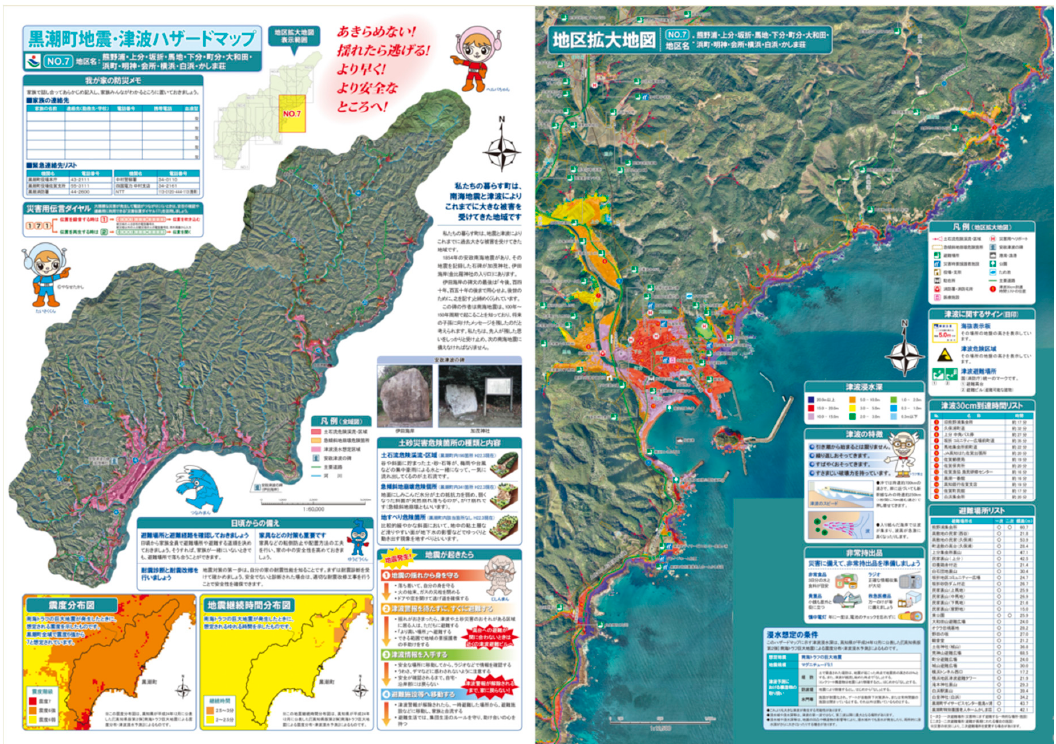
Figure 2. The tsunami inundation estimate of Kuroshio Town and the hazard map of the region which would be severely affected.